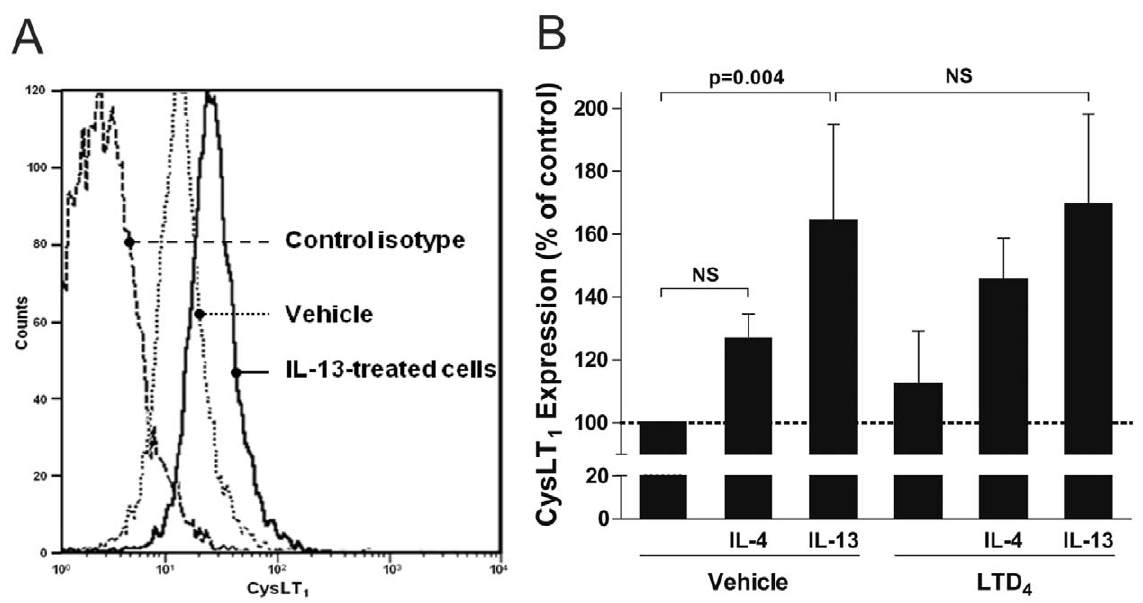
Figure 5. Effect of IL-13, IL-4 and/or LTD 4 on CysLT 1 expression by airway epithelial cells. Airway epithelial cells were treated with vehicle, 10 ng/ml IL-4, 10 ng/ml IL-13 and/or 100 nM LTD 4 for 6 hours. Incubations were stopped by removing the incubation media and cells were harvested, processed, and analyzed for CysLT 1 expression by flow cytometry as indicated in Material and Methods . A. Representative histograms of CysLT 1 expression (control isotype, open bar; baseline expression, gray plot; IL-13-treated airway epithelial cells). B. Data represent the mean ( 6 SEM) of three separate experiments. NS=not significant.